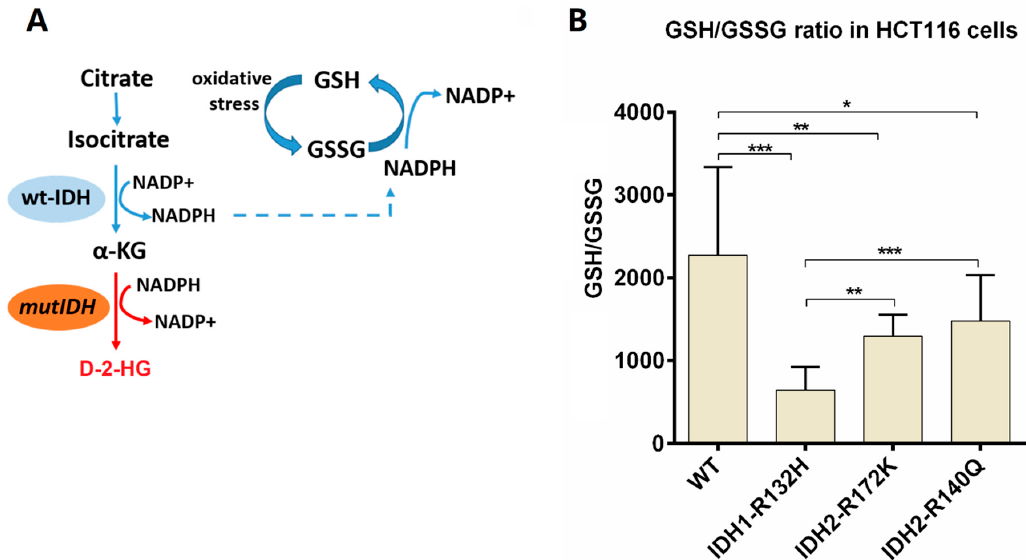
Figure 7. ( A ) Scheme depicting the reactions catalyzed by wild type and mutant IDH enzymes and their respective effects on the provision of NADPH for the reduction of GSSG to GSH by glutathione reductase. ( B ) Effect of different IDH1/2 mutations on the GSH/GSSG ratio in HCT116 cells compared to IDH1/2 wild type cells. * p < 0.05, ** p < 0.01, *** p < 0.001, n = 3, for further statistics see Supplementary Table S5.